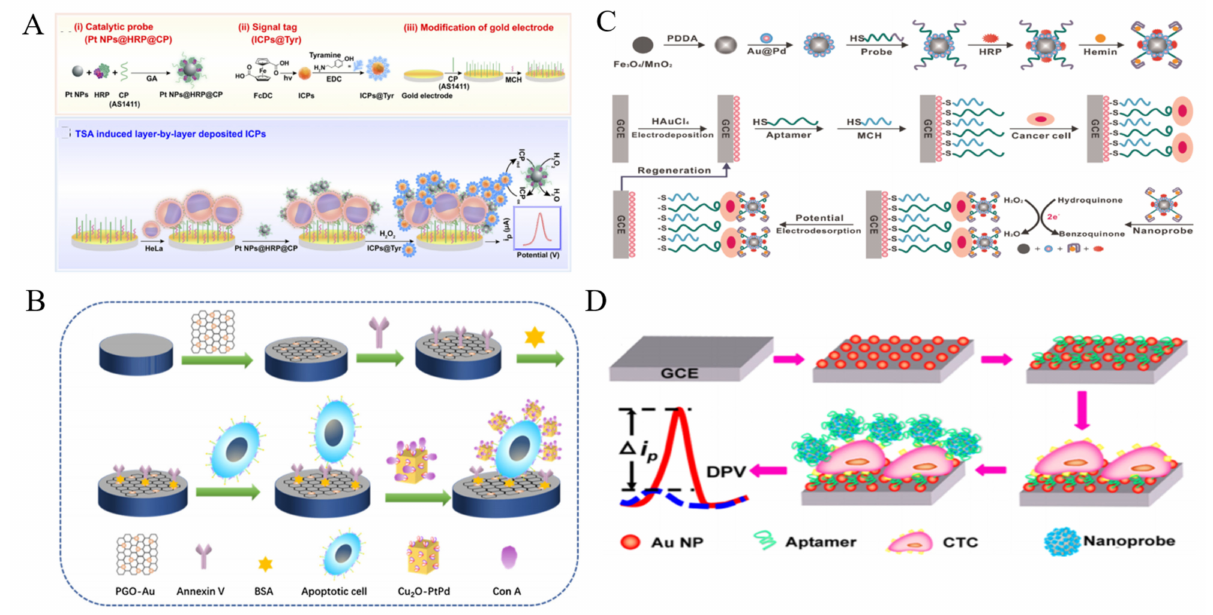
Figure 10. ( A ) Schematic representation of electrochemical immunosensor for CTCs (HeLa cell as a model) detection based on TSA induced layer-by-layer deposited ICPs [180]. Copyright 2019 Elsevier B.V. ( B ) Schematic